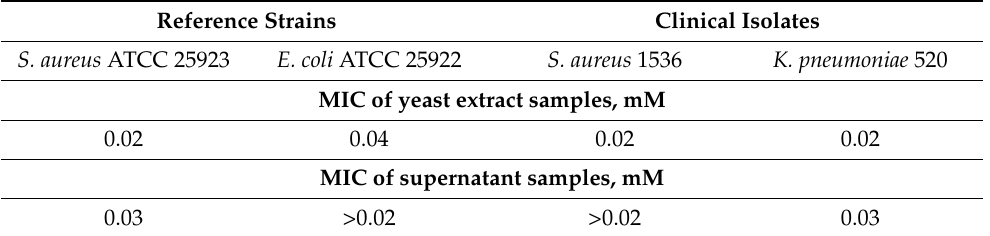
Table 2. Minimum inhibitory concentration (MIC) of samples by MTT test.